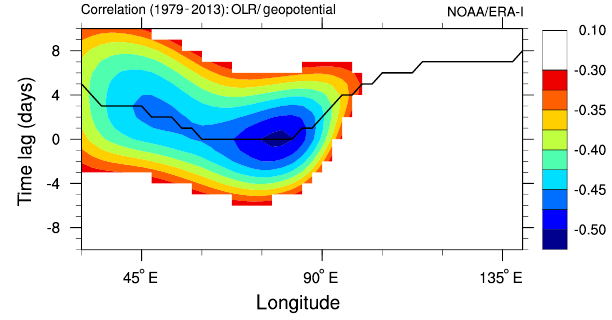
Figure 13. Correlation between NOAA OLR (averaged over 15– 30 ◦ N × 70–130 ◦ E) and ERA-I geopotential (averaged over 20– 40 ◦ N) at 100hPa depending on time lag and longitude. Positive lags indicate that geopotential changes occur after OLR changes. Correlation is calculated based on the deseasonalised and smoothed (periods shorter than 10 days removed) time series from May to September for every year separately and then averaged over the 35 year period 1979–2013 (period covered by OLR and geopoten- tial data). The black line shows the maximum anticorrelation at each